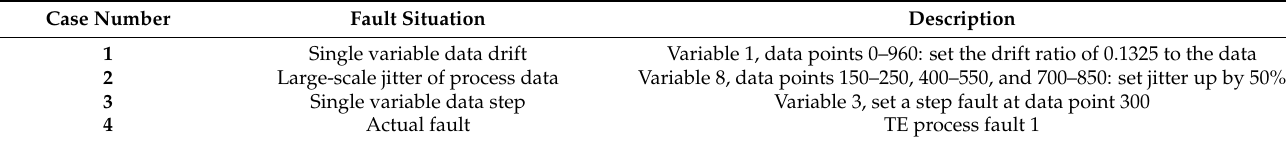
Table 3. Four faults in TE